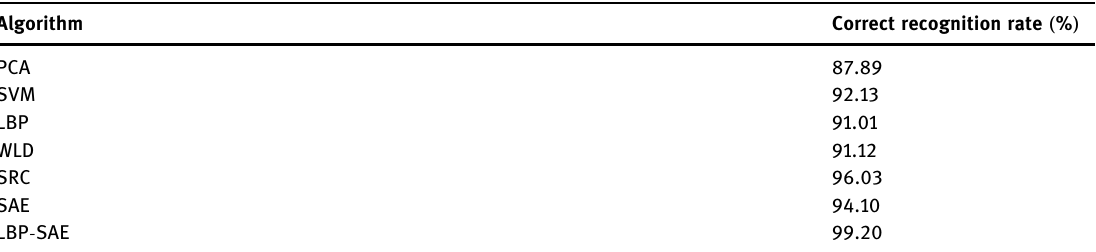
Table 2: Correct recognition rate of di ff erent algorithms on ORL library Algorithm